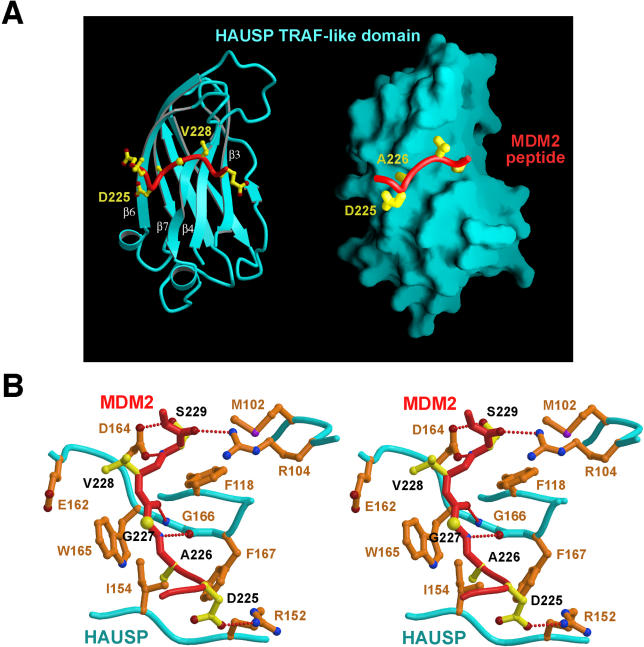
Structural Basis of MDM2 Recognition by HAUSP(A) Overall structure of the HAUSP TRAF-like domain bound to MDM2 peptide is shown in a ribbon diagram (left) and in a surface representation (right). The important MDM2 residues are highlighted in yellow.(B) A stereo view of the specific interactions between MDM2 and HAUSP. These interactions are more extensive than those between p53 and HAUSP. Hydrogen bonds are represented by red dashed lines. All interacting residues are labeled.